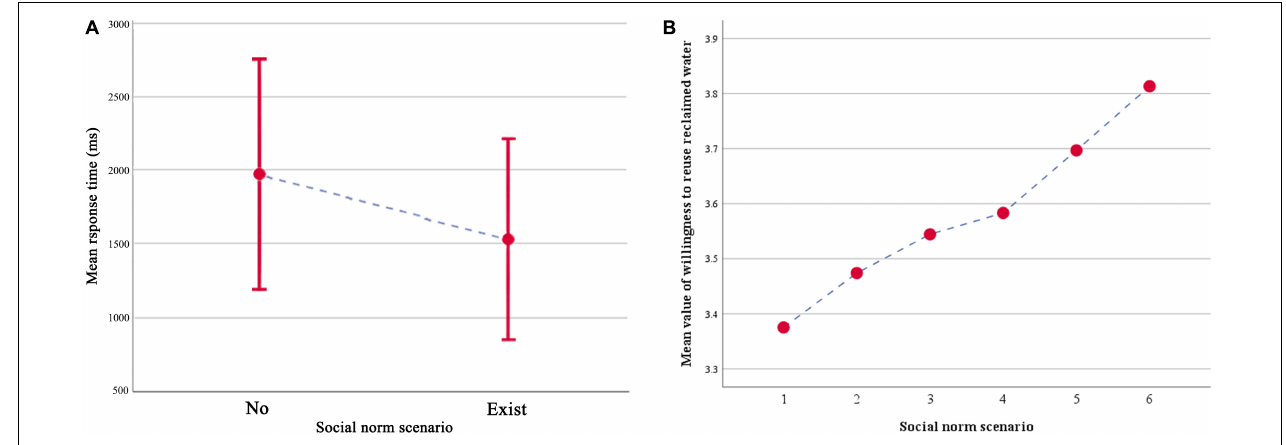
FIGURE 5 | (A) The mean response time of Task 1 with no social norm and Task 2 with the social norm. Error bars depict the standard error of the mean. (B) Take the social norm value in Task 2 as a function of a priori